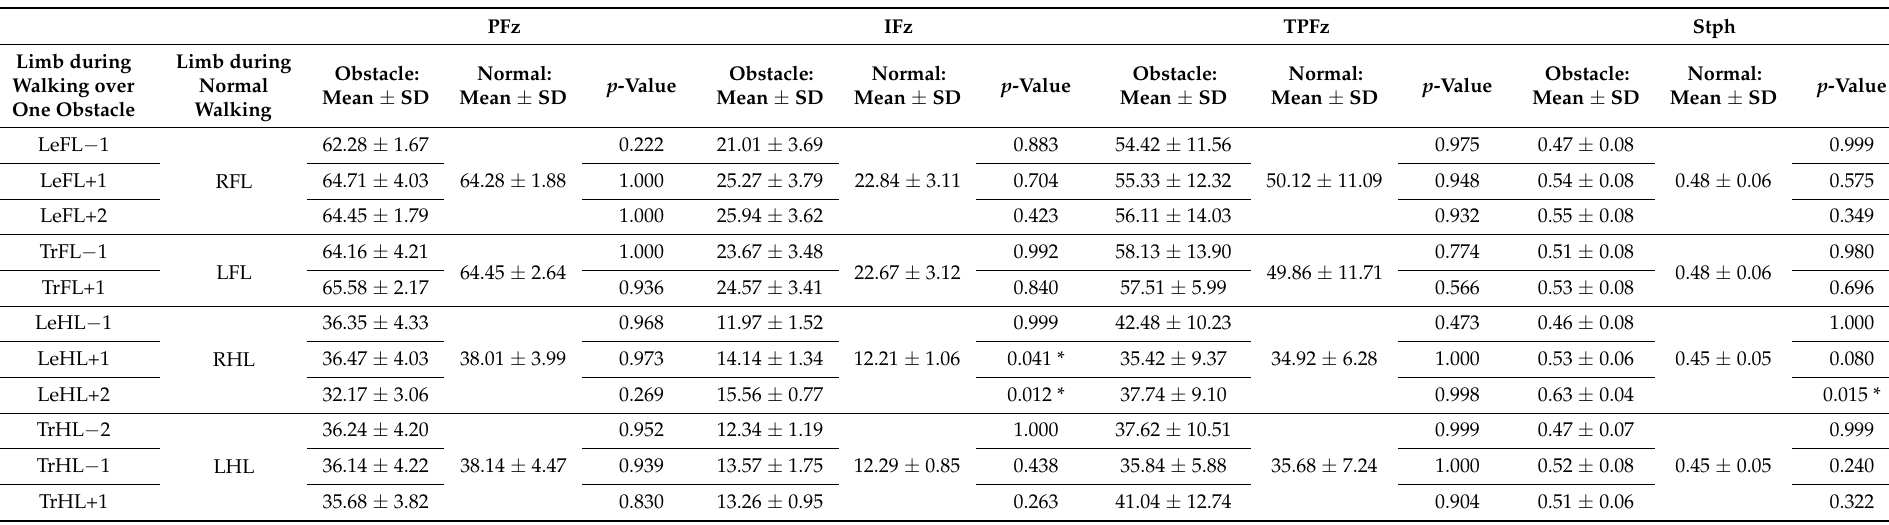
Table A1. Mean values, standard deviations, and significant differences in ground reaction forces between walking over one obstacle and normal walking. PFz IFz TPFz Stph Limb during Limb during Walking over Normal One Obstacle